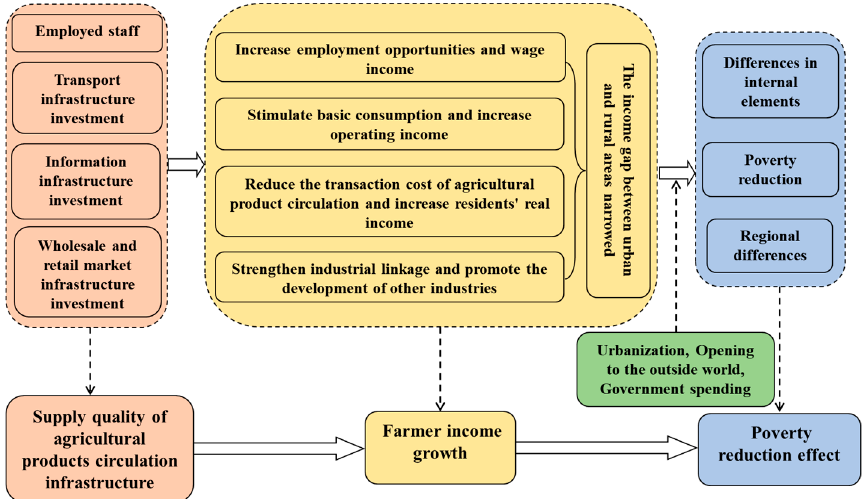
Figure 1. The internal logical relationship between the supply quality of agricultural products circulation infrastructure and poverty reduction.